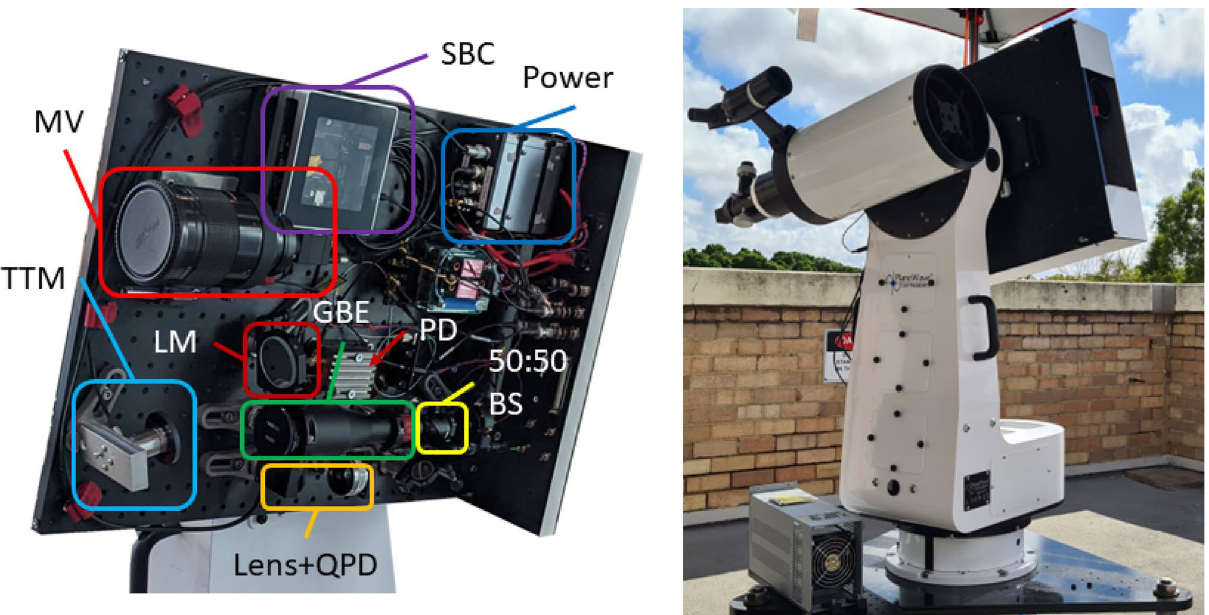
Figure 2. Left: the optical breadboard layout. MV Machine vision lens and camera, TTM tip/tilt mirror, LM static launch mirror, GBE Galilean beam expander, QPD quadrant photodetector, SBC single board computer, PD photodetector, BS beamsplitter. Right: the deployed optical terminal. Optics and MV are located on the far side of the breadboard. The tip/tilt control electronics are visible on the lower left of the mount base. The telescope mounted on the left was not used for this